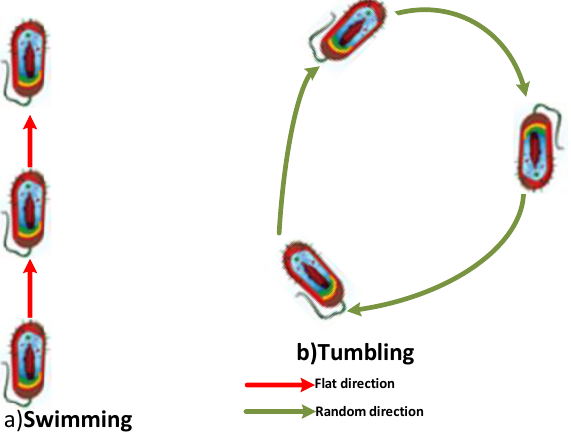
Figure 4. A sample of bacteria chemotaxis movements.